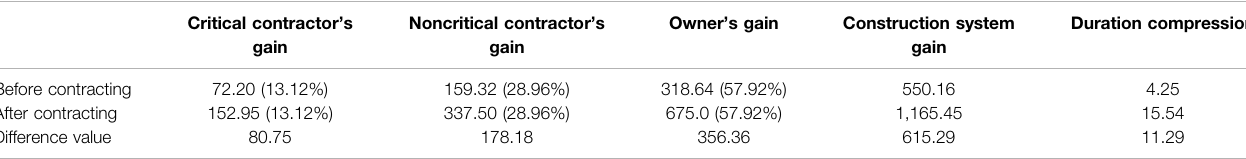
TABLE 8 | Comparisons of the gain functions and construction durations in Scenario